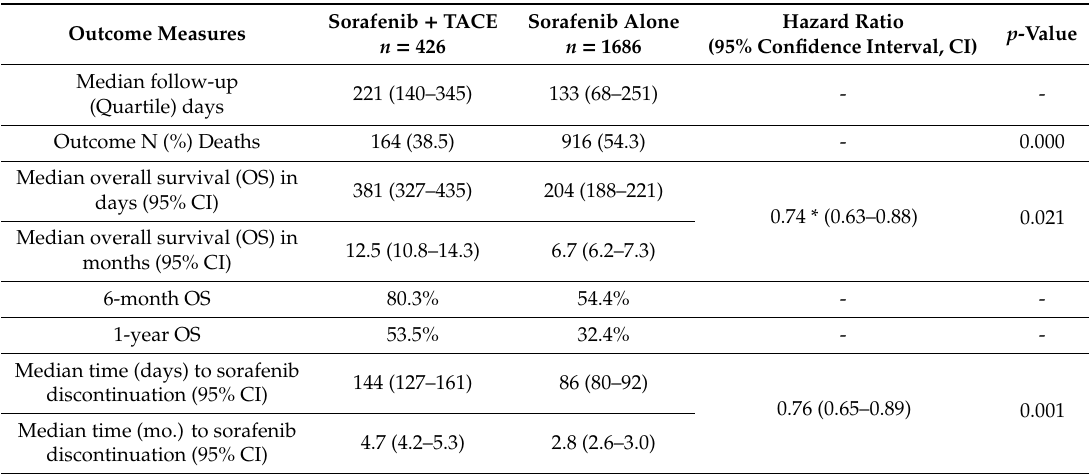
Table 2. Efficacy outcomes stratified by sub-cohorts with or without TACE after propensity score E ffi cacy outcomes stratified by sub-cohorts with or without TACE after propensity matching. score matching.